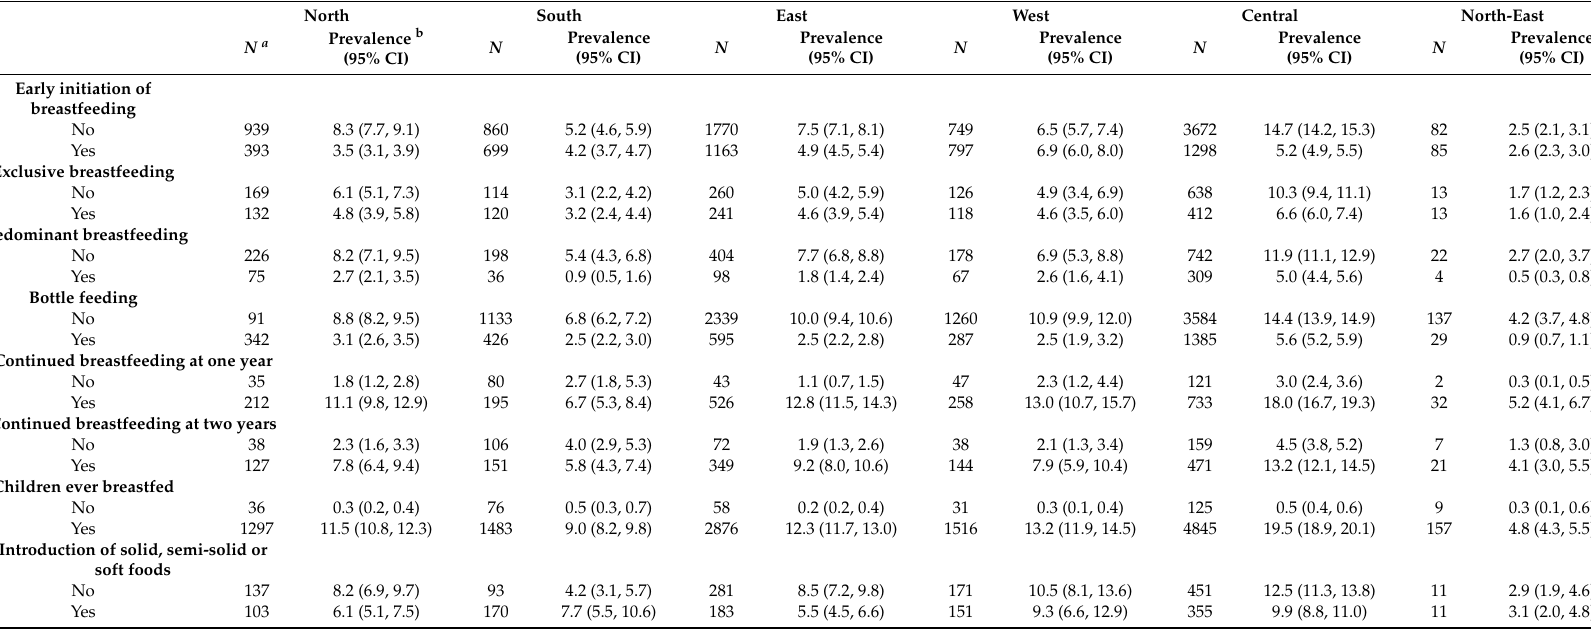
Table 1. Prevalence and 95% confidence intervals (CIs) of diarrhoea among children aged 0–23 months by infants and young child feeding practices in regional India (N =